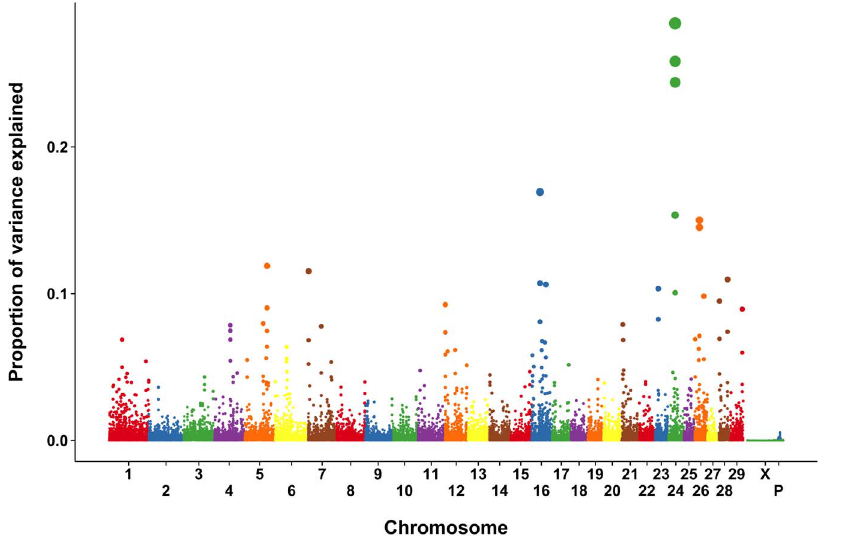
Figure 1. Proportion of SNP variance explained by 3-SNP moving windows for rectal temperature from a single-step GBLUP analysis.